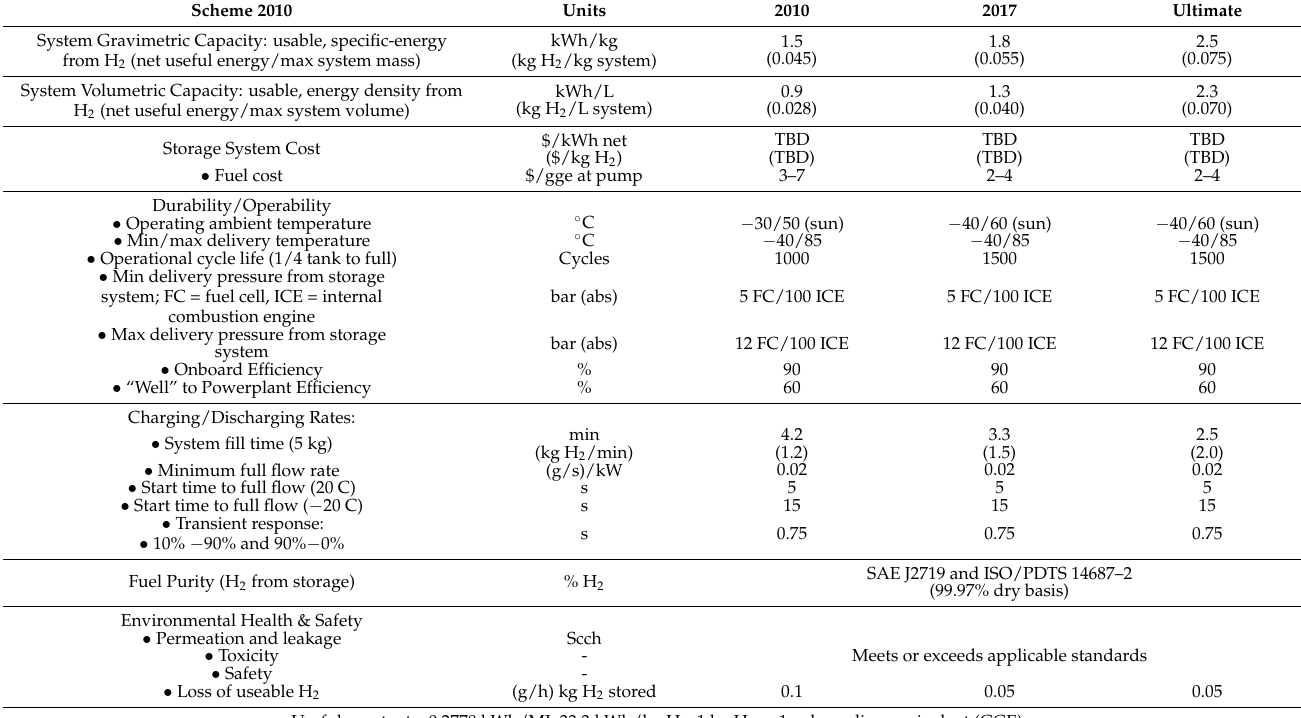
Table 1. U.S. Department of Energy (DOE) targets for on-board hydrogen storage systems for light-duty vehicles [1]. Scheme 2010 Units